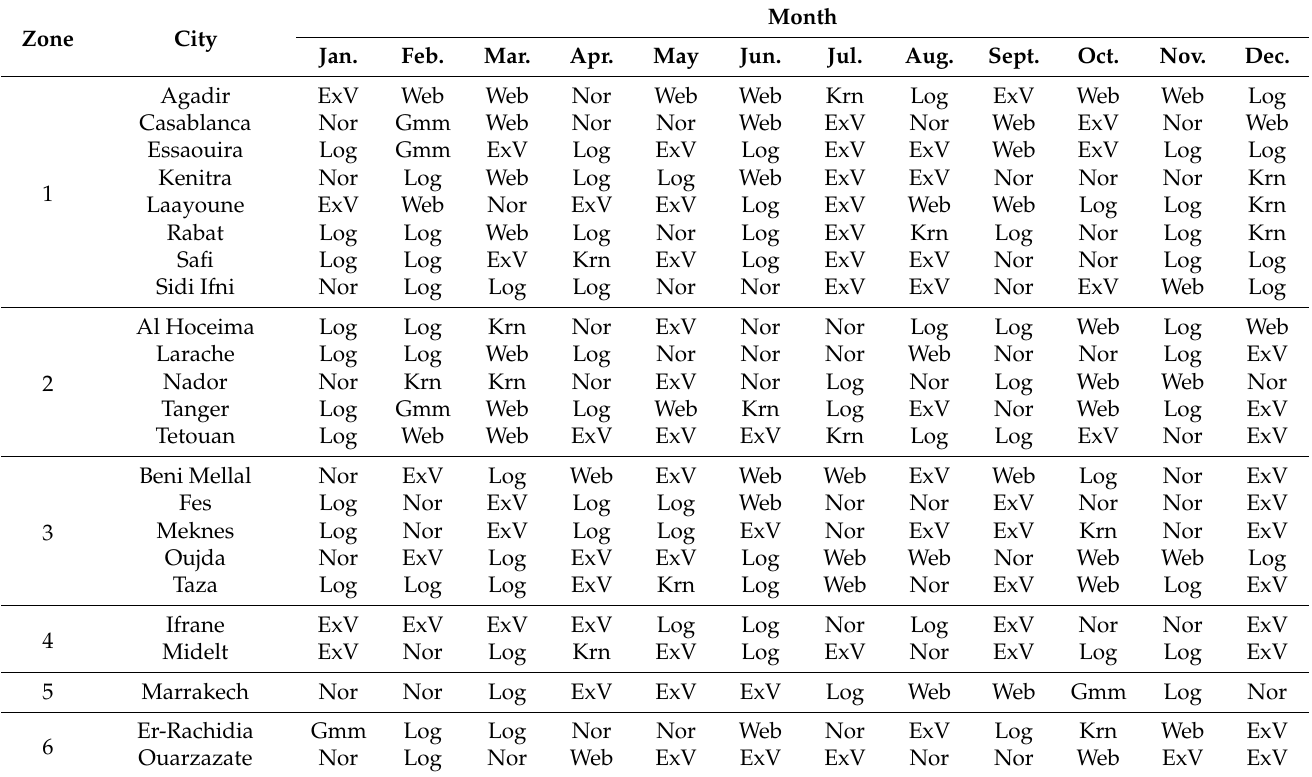
Table 7. PDFs for the GHI case for each city and month (normal = Nor, Logarithmic = log,